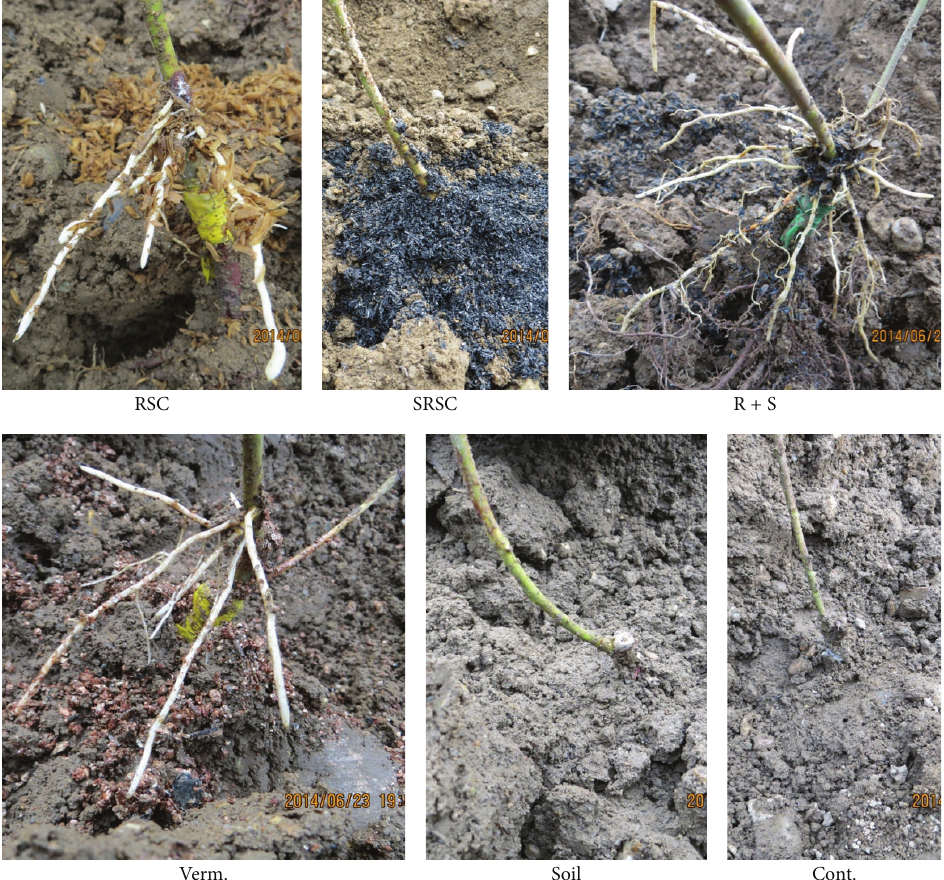
Figure 1: “M.9” roots produced after one-month treatment of rice seed coat (RSC), smoked rice seed coat (SRSC), combined 50% RSC and 50% SRSC (R + S), vermiculite (Verm.), soil (Soil), and no soil